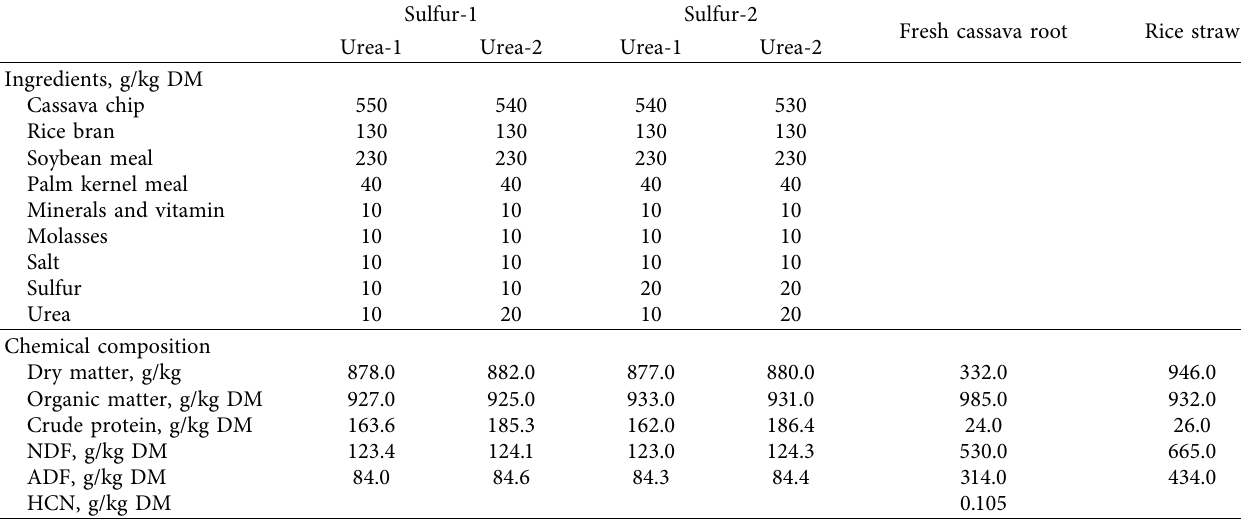
Table 1: Ingredient and chemical composition of concentrate, cassava roots, and rice